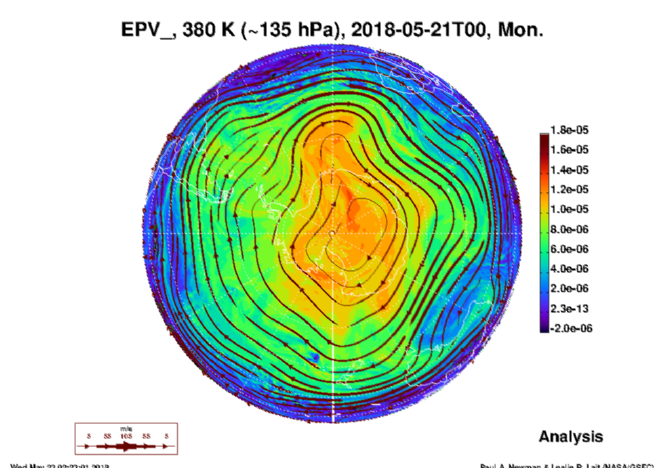
Figure 1. Ertel’s potential vorticity (EPV) generated from analyzed wind data at the 380 K potential temperature level, i.e., in the Antarctic stratosphere at approximately 14 km altitude. Plot shows EPV on 21 May 2018, in units of K × m 2 (see kg s